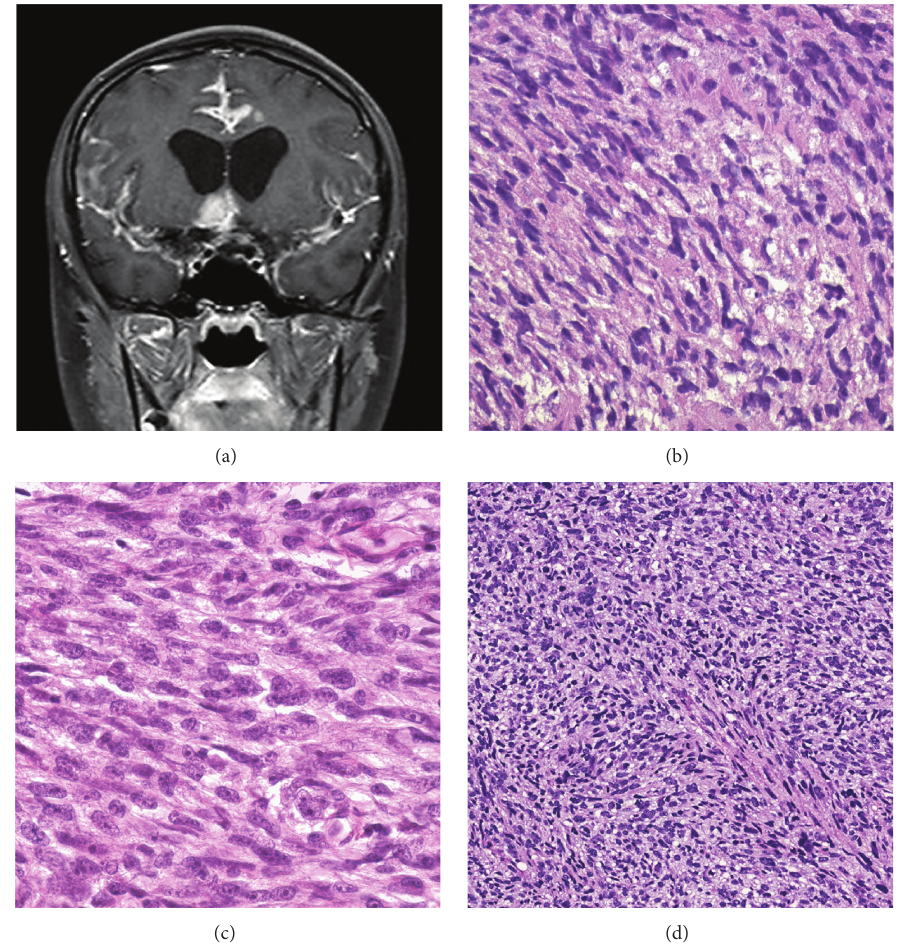
Figure 1: Radiographic imaging and comparative histology of human and PDX tumors: (a) 1cm × 2 cm enhancing right-sided skull based mass that was invading the hypoglossal nerve canal. (b) H&E slide, 400x of brain biopsy showing sheets of elongated spindled cells with eosinophilic cytoplasm and a myxoid background, consistent with embryonal rhabdomyosarcoma. An H&E slide, 400x from the frontal lobe at autopsy (c), and a section of mouse xenograft, 200x (d), show highly similar morphologic